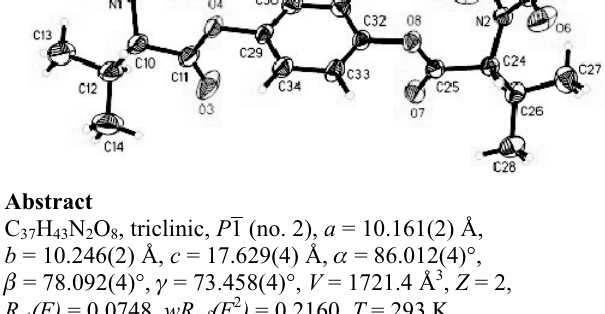
Table 1. Data collection and handling.